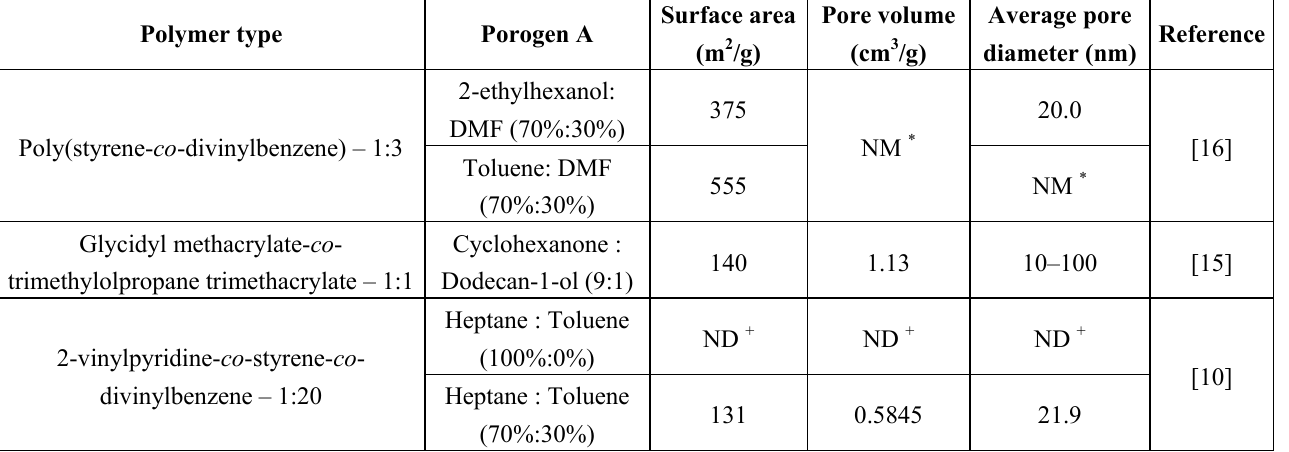
Table 2. Surface area (from nitrogen porosimetry), pore-volume, pore-size and average pore diameters of PCR materials synthesized in presence of various solvent mixtures. The synthesis conditions were outlined in Section